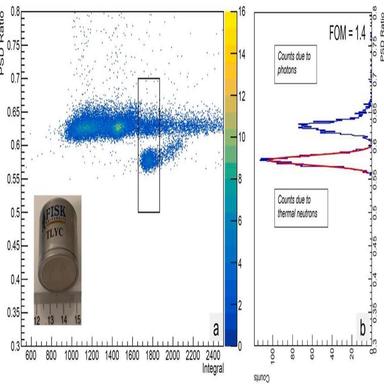
Characterization of on a ∅1″ × 1″ TLYC crystal (grown, processed, and hermetically encapsulated at Fisk) conducted at FLIR (a) PSD scatter plot created using the waveforms generated by thermalized 252Cf neutron source in the TLYC crystal. (b) Projection of the events enclosed in the box shown in the scatter plot results in FOM of 1.4.